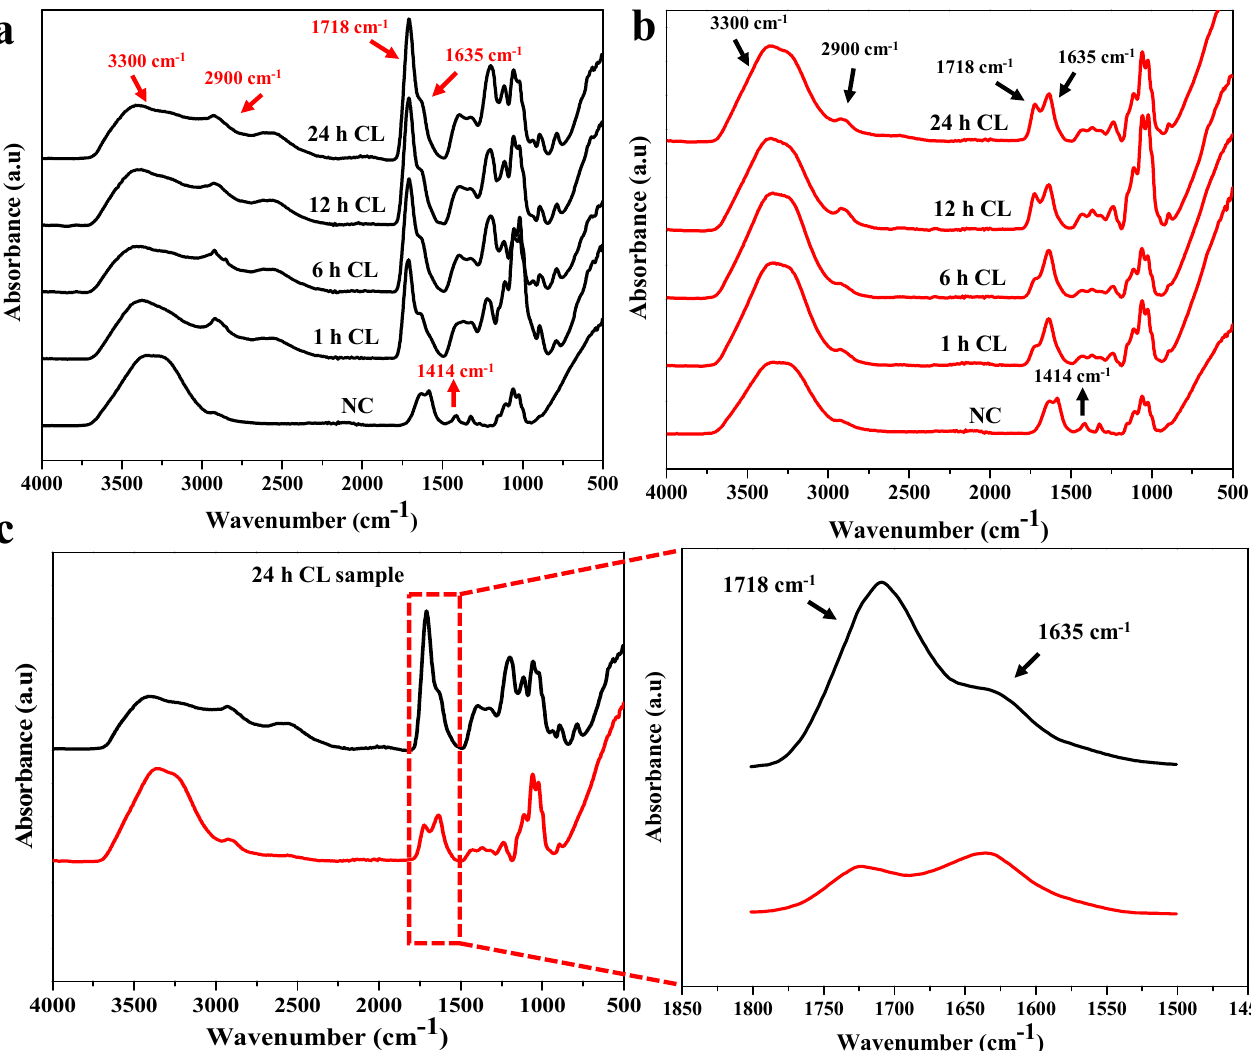
Figure 2. FTIR spectra of CG01 ( a ) and CG02 ( b ) hydrogel based on varying immersion times in crosslinker solution, and ( c ) compositional spectral analysis of 24 h crosslinked samples of both CG01(black line) and CG02 (red